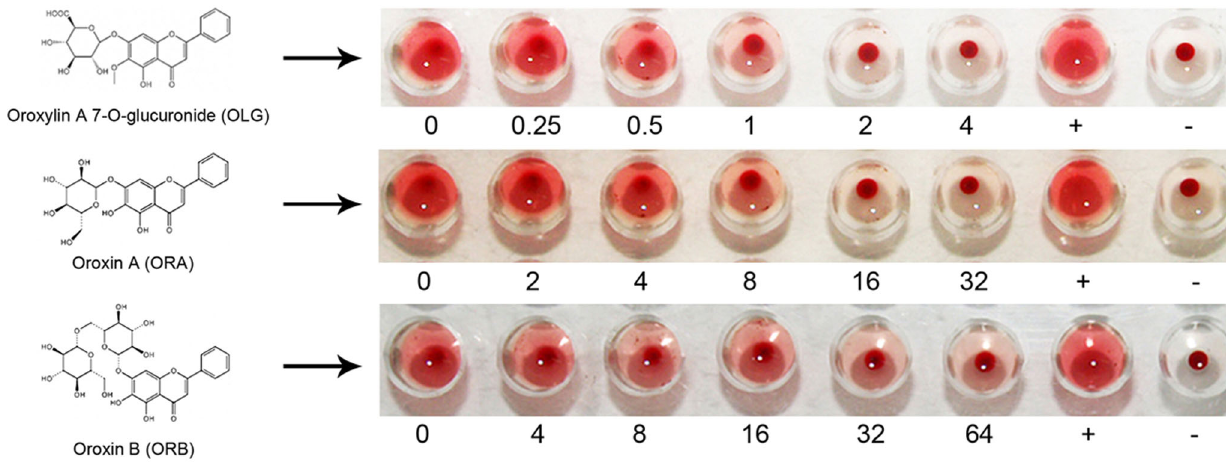
Figure 1. Hemolytic activity of a -HL after treating with increasing concentrations ( m g/ml) of OLG, ORA and ORB. ‘‘ + ’’ indicates the positive control while ‘‘-’’ indicates the negative control.